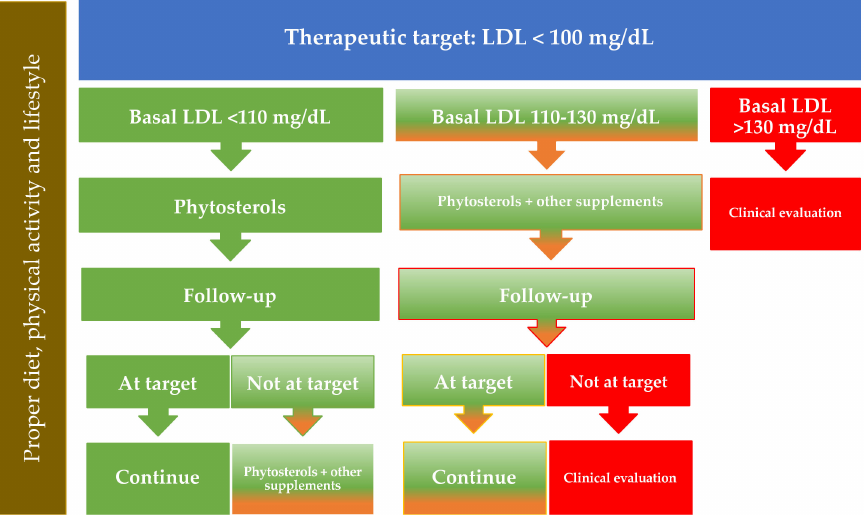
Figure 3. Flowchart B. Patient ≥ 40 years old with global cardiovascular risk 1–5%. This flow-chart is not appropriate for patients with genetic disorders of lipoprotein metabolism or with manifest cardiovascular disease, who need to be treated according to the